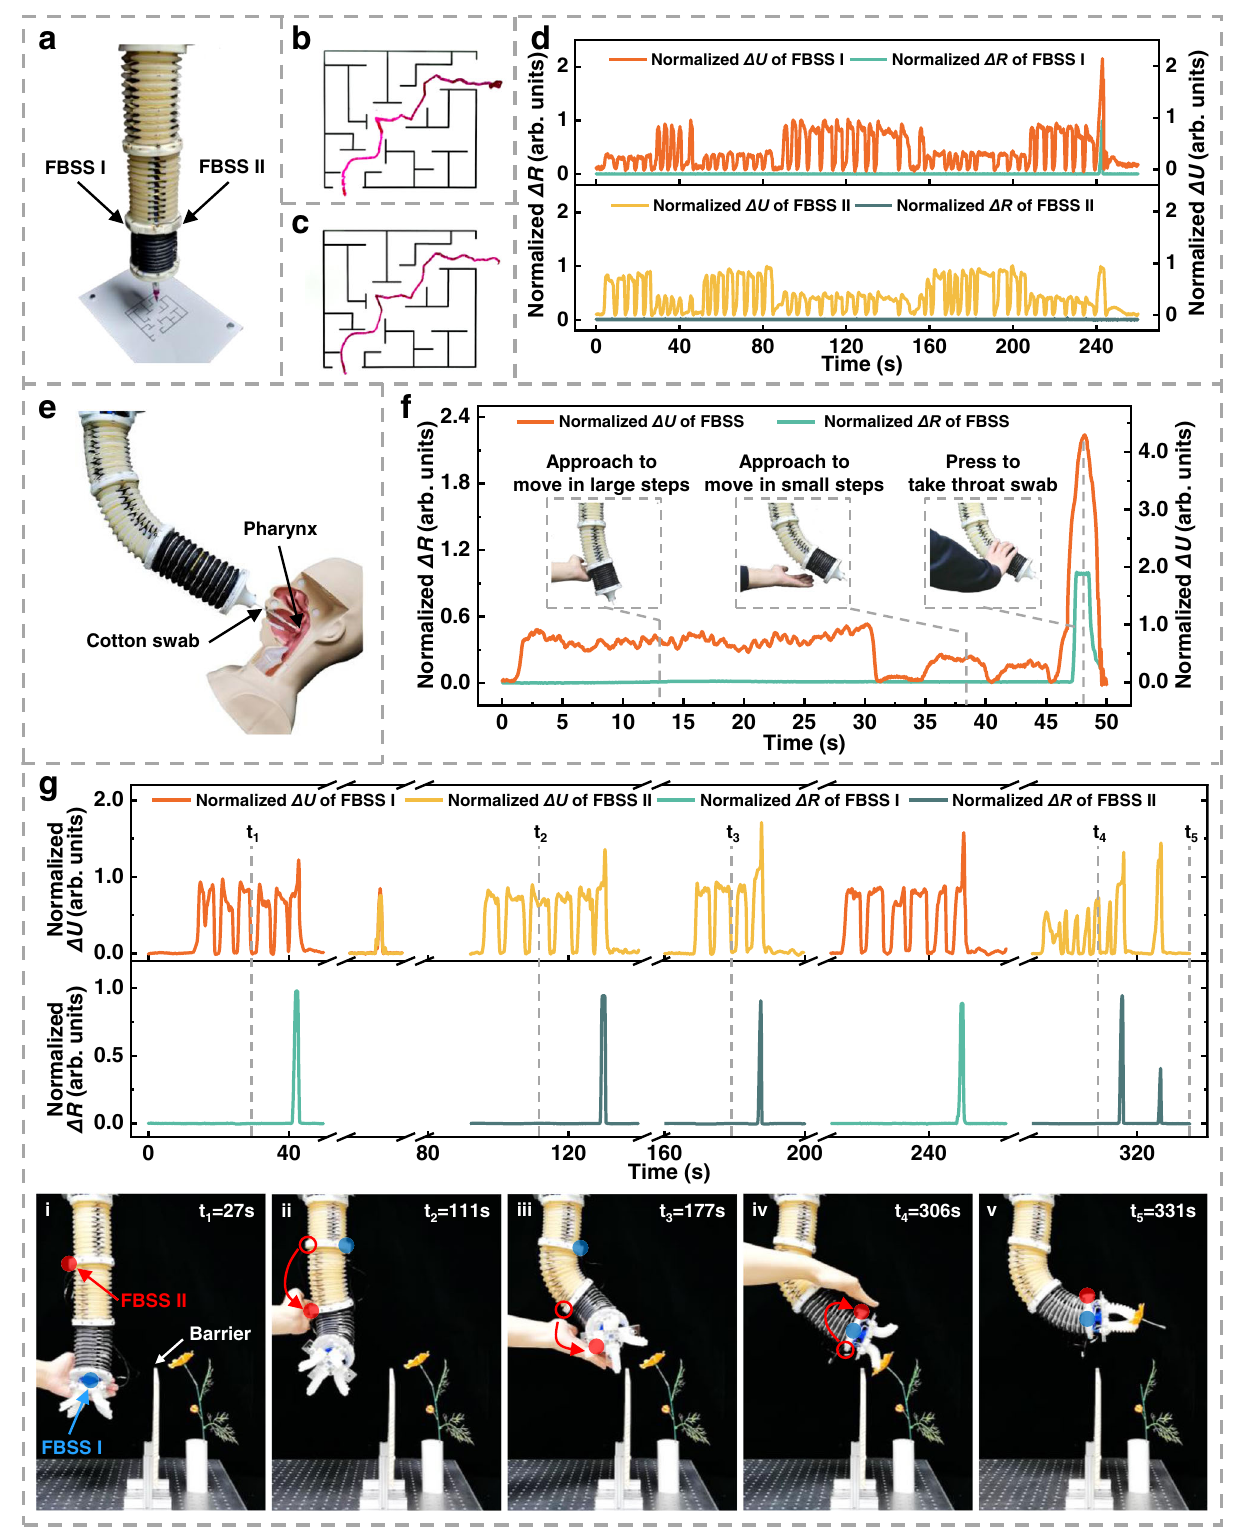
Fig. 8 | Demonstrationofpotentialapplicationsforinteractively teachingself- reacting soft robots. a Photograph of the experimental setup for teaching a soft manipulator to complete a maze. b , c The manipulator ’ s maze traces during teaching and repeating processes. d Signal curves during the maze completion